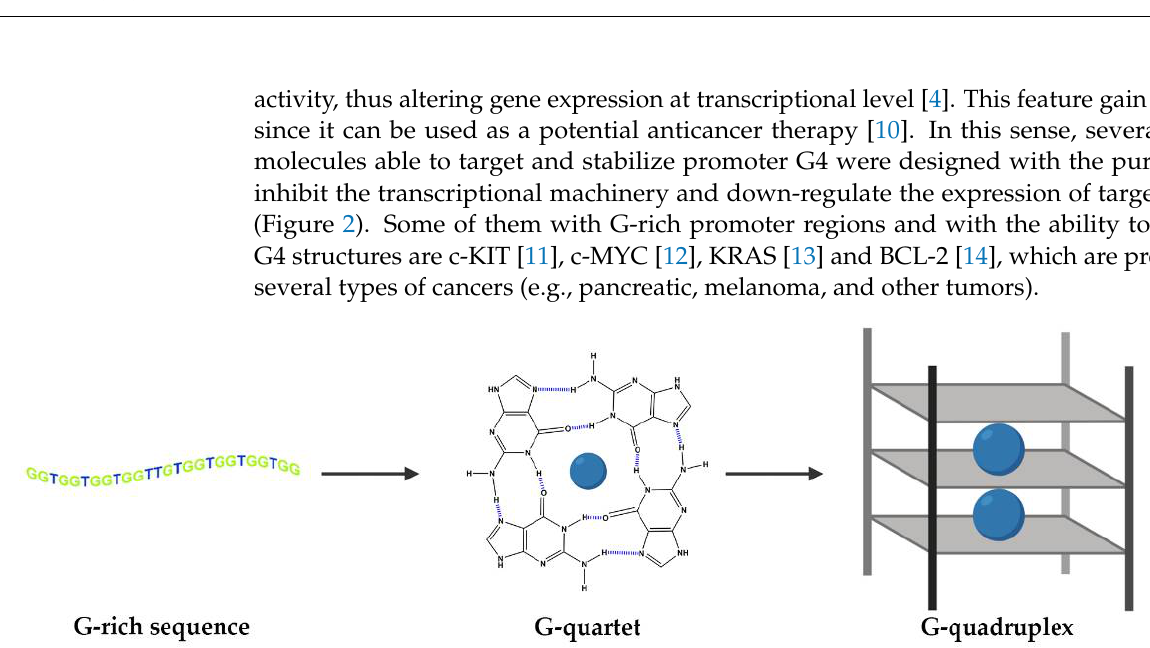
Figure 1. G-tetrads are formed by four guanines bonded via Hoogsteen base pairing. G4s comprise three stacked G-tetrads connected by loops. They are stabilized by monovalent cations coordinated in the central cavity (represented by blue spheres).